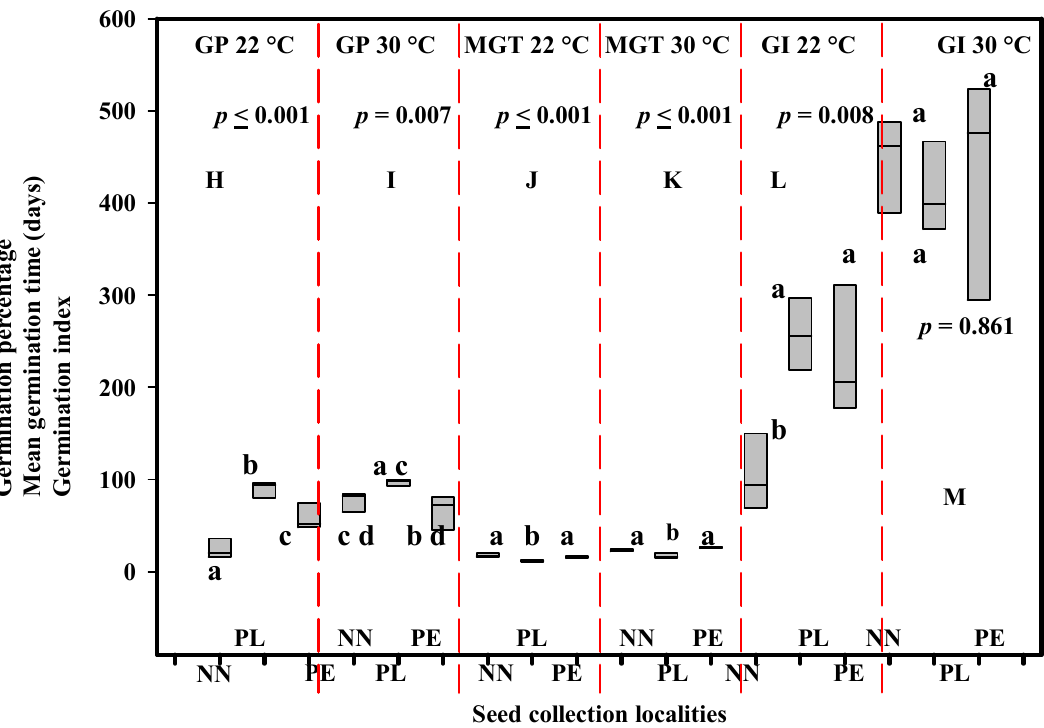
Figure 6. ANOVA results for comparison of the effects of seed collection localities/sources (Sirhin (NN), Firmihin (PL), and Skant (PE)) on the germination percentage (GP), mean germination time (MGT), and germination index (GI) of D. cinnabari seeds. Means with the same letter are not significantly different from each other ( p = 0.05). Figure 6 H and I represent GP at 22 °C and 30 °C temperature, respectively. Figure 6 J and K represent MGT at 22 °C and 30 °C temperature, respectively. Figure 6 L and M represent GI at 22 °C and 30 °C temperature, respectively.